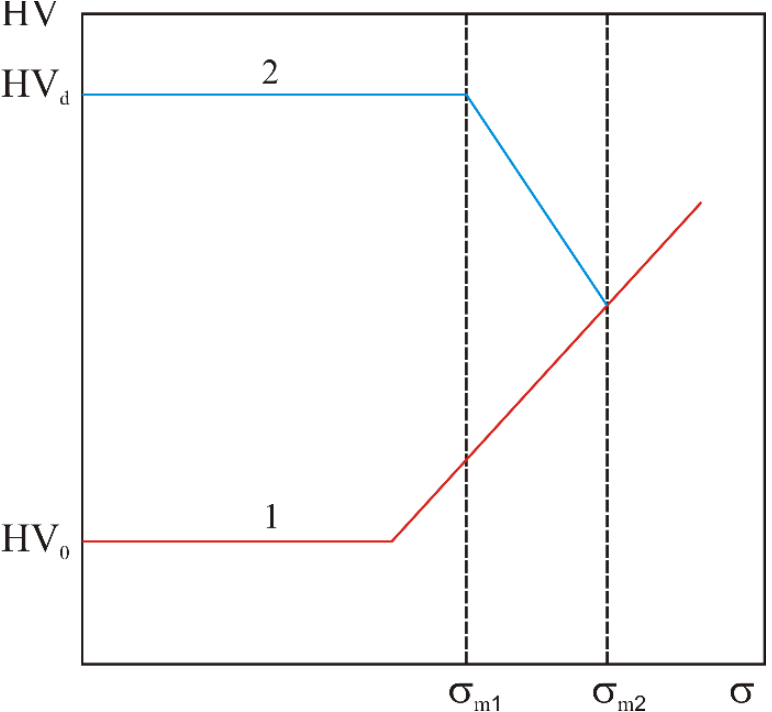
Figure 10. Amplitude dependencies of the microhardness during UST. Curve 1—annealed sample, UST up to the stage of saturation; Curve 2—deformed sample, after time interval corresponding to the minimum of microhardness [58].